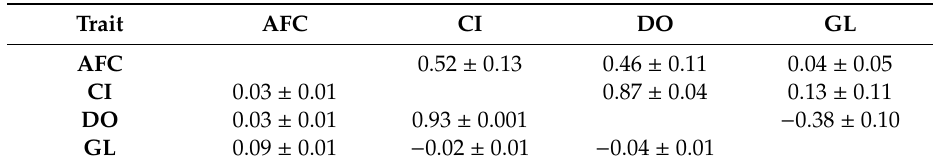
Table 4. Genetic (above diagonal) and phenotypic (below diagonal) correlations among reproductive traits of Hanwoo